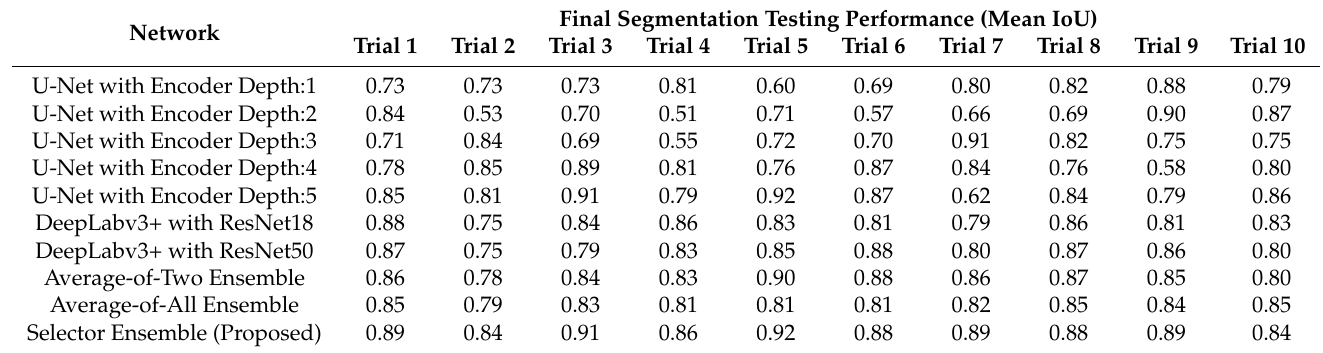
Table A2. Mean IoU values of the final lung segmentations obtained during testing with the ’selected’ cases out of 140 chest radiographs from the JSRT